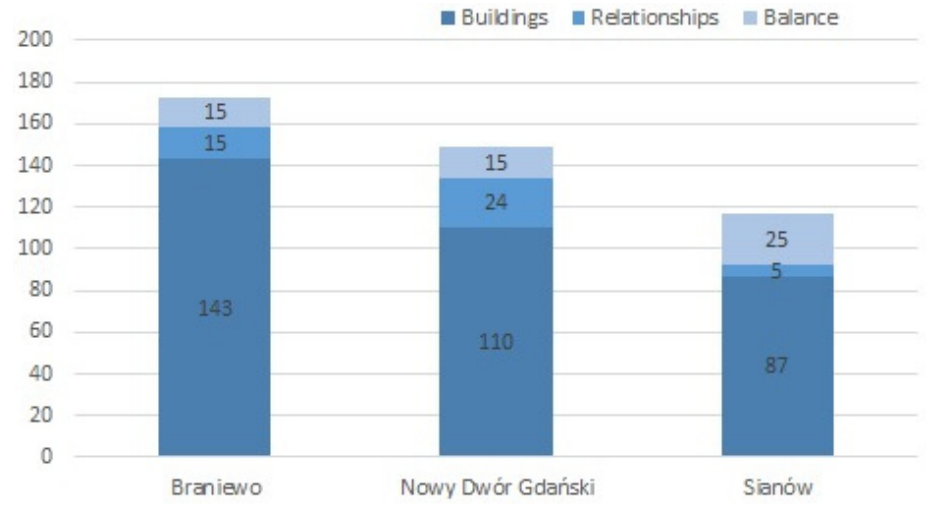
Figure 6. Attractiveness of the cultural qualities of three Polish coastal Cittaslow towns to tourists and natives.